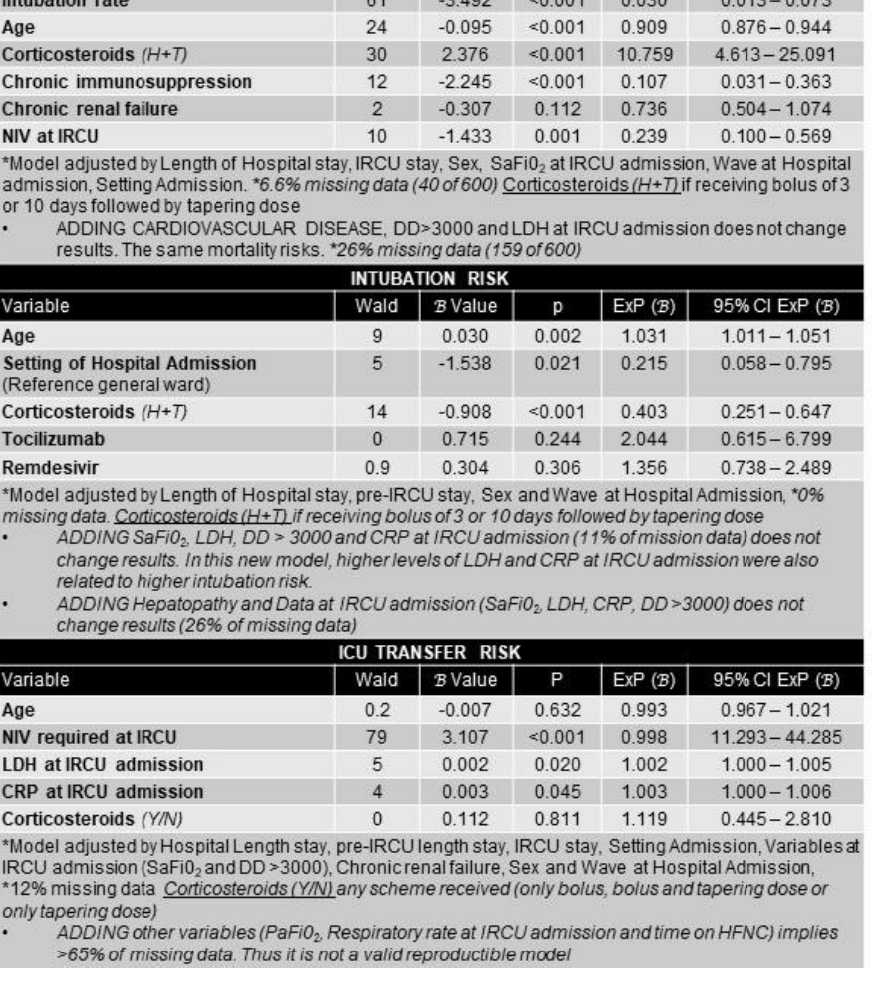
Figure 3. Multivariate logistic regression analysis. Factors associated with survival, ICU transfer, and intubation in the entire cohort.